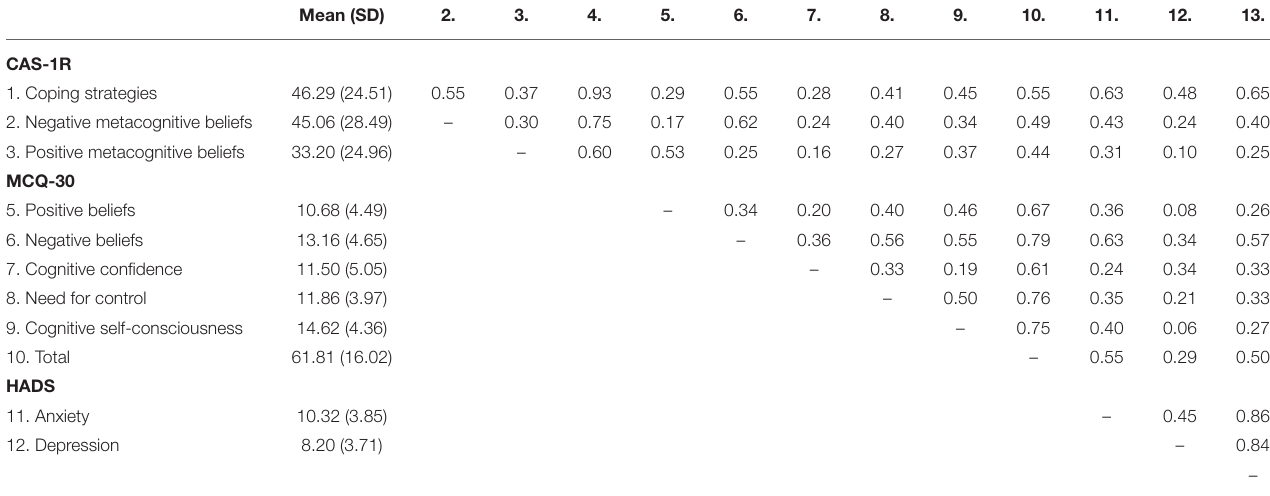
TABLE 4 | Descriptive statistics and correlations for psychological measures (i.e., CAS-1R, MCQ-30, and HADS).